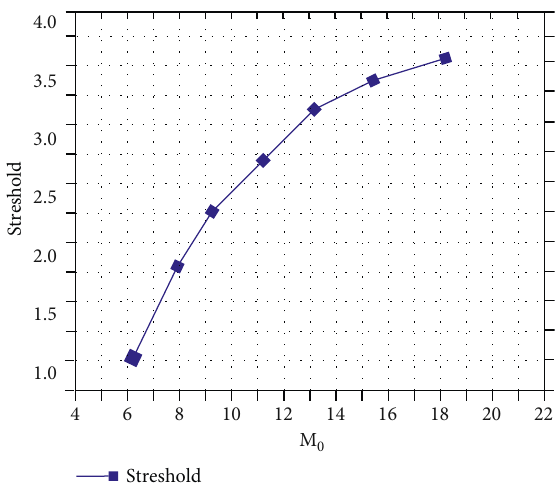
Figure 5: The one-dimensional steady-state shock problem. Dis- tribution curve of the stable threshold of entropy S � log ( p / ρ c ) − log ( p L / ρ L ) as a function of the Mach number. The method of numerical experiment is used for further analysis.